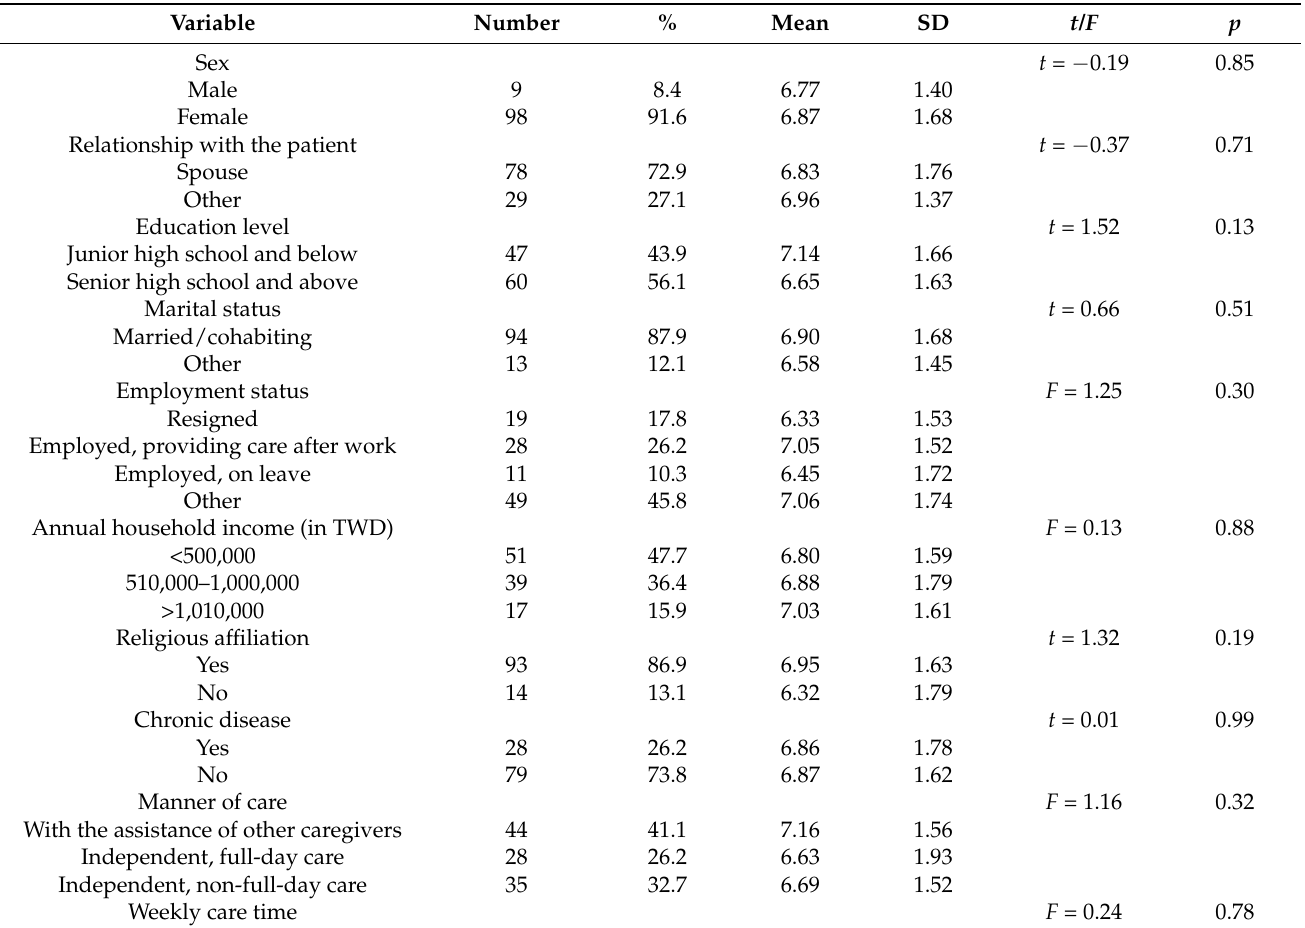
Table 1. Sociodemographic variables of the primary family caregivers and the differences in overall caregiving self-efficacy between or among groups ( n =